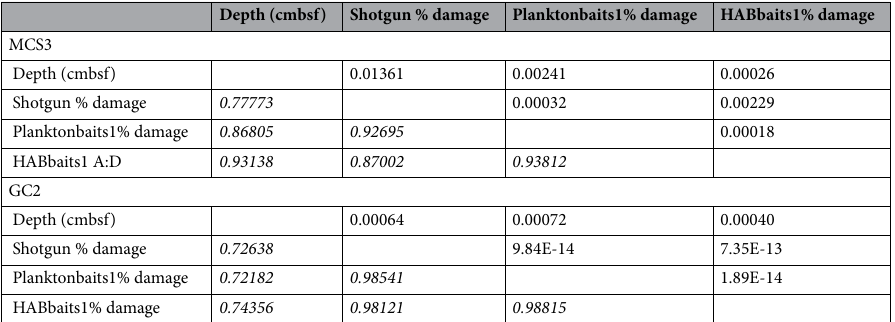
Table 2. Summary statistics of correlation analysis between % eukaryote sed aDNA damage and subseafloor depth. Pearson correlation coefficients r (in italics, lower matrix triangle) and corresponding two-tailed probability that r is uncorrelated (upper triangle of matrix; i.e. , all values < 0.05 denote a significant correlation) between subseafloor depth (cmbsf) and Shotgun, Planktonbaits1 and HABbaits1% eukaryote sed aDNA damage (n = 27